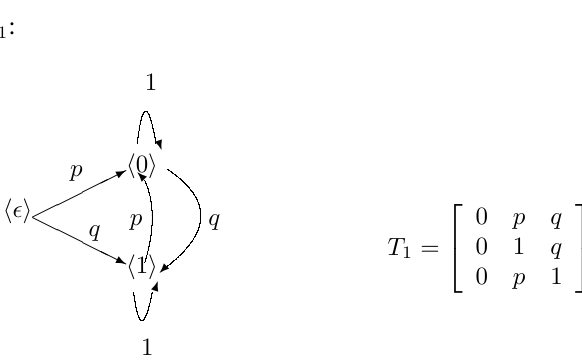
Figure 2: Directed graph A 1 and the matrix T